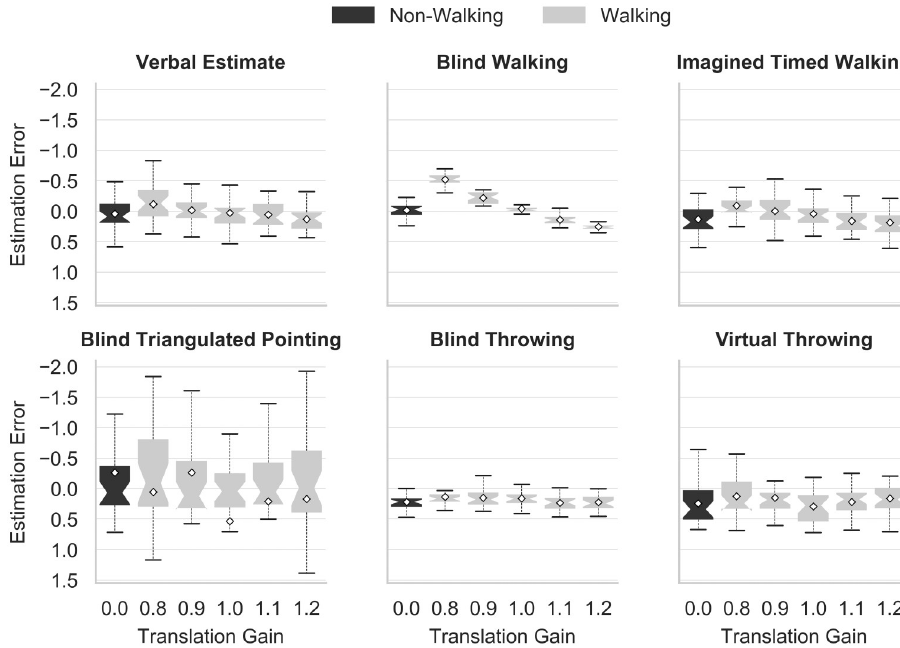
Fig 5. Translation gain factor plot over method. Factor plot displaying each method and the associated influence of translation gain. A translation gain of 0.0 corresponds to non-walking trials.